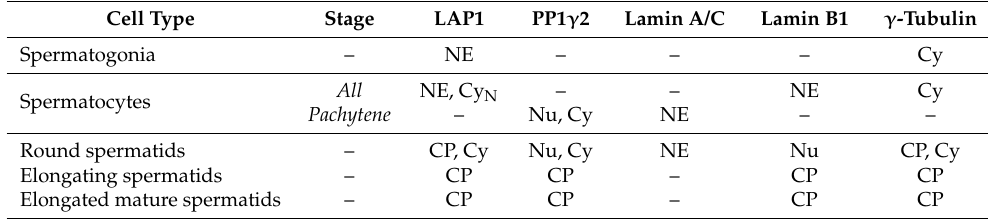
Table 2. Cellular and subcellular localization of LAP1 and its interactors during the cycle of spermatogenesis in human